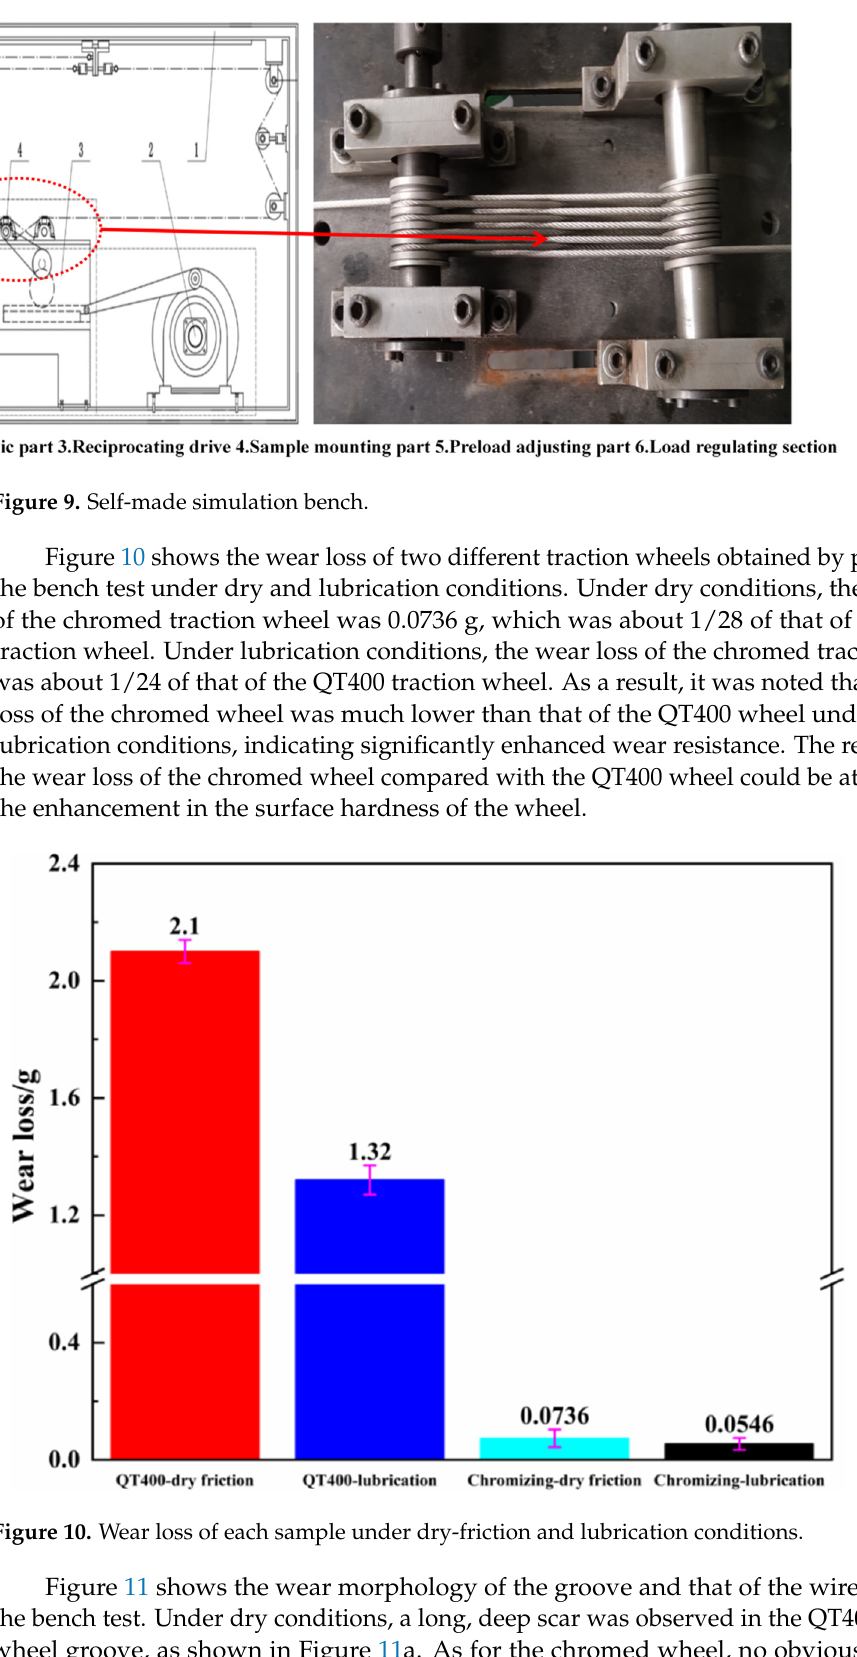
Figure 10. Wear loss of each sample under dry-friction and lubrication conditions.